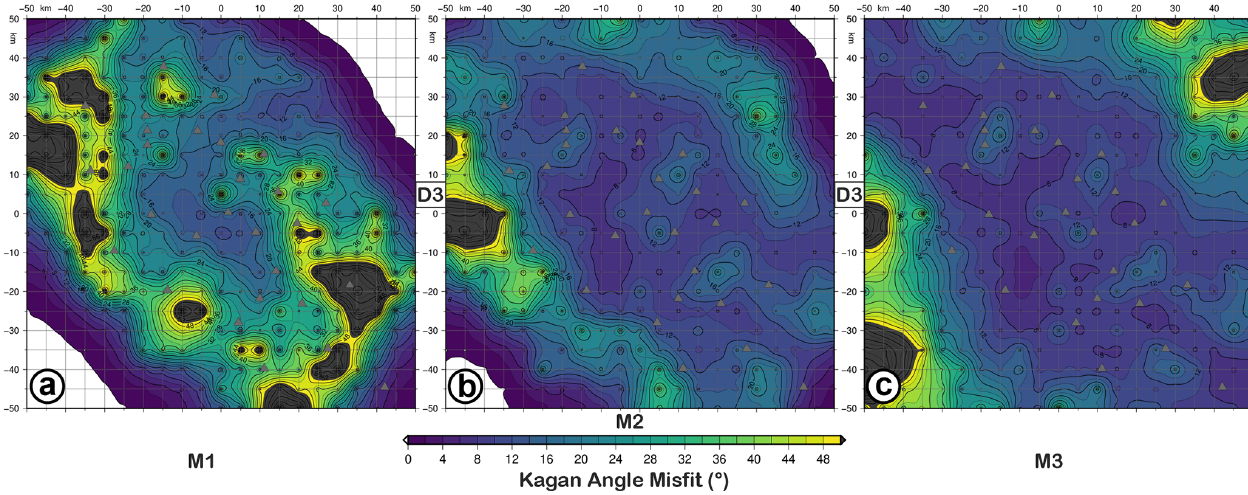
Figure 12. KAM (Kagan angle misfit) map for retrieved focal mechanisms with D3 (a–c) datasets as input data and simulating earthquakes with M1 (a) , M2 (b) , and M3 (c) magnitudes and the FM1 theoretical fault plane solution at 10km depth. The level of Gaussian noise is set to